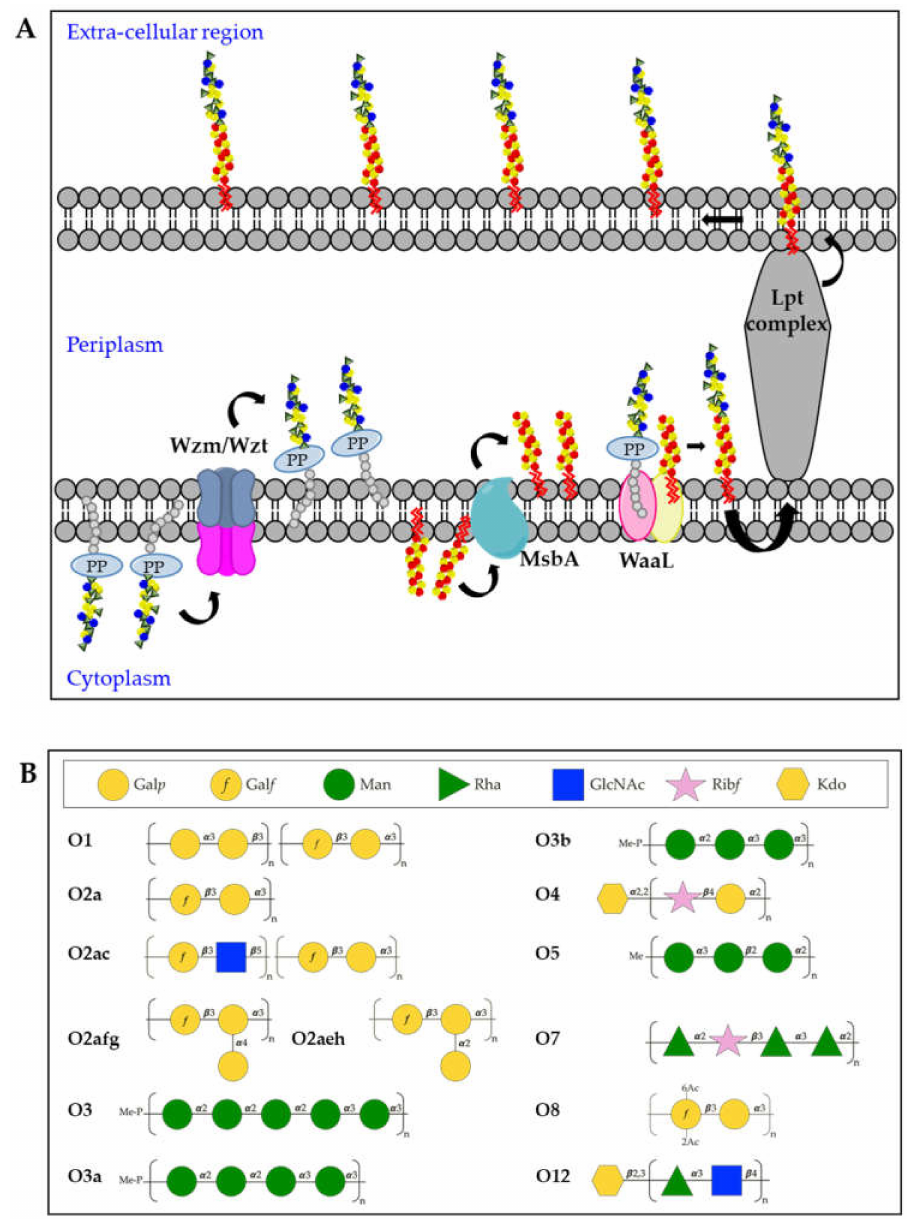
Figure 3. ( A ) Model of O-antigen biosynthesis via the adenosine triphosphate-binding cassette (ABC) transporter pathway. Und-PP-linked O-polyaccharides are processively assembled on the cytoplasmic leaflet of the inner membrane, through the sequential activity of different glycosyltransferases. The assembled O-antigen component is then transported via the Wzm/Wzt ABC transporter across the inner membrane. In the periplasmic leaflet of the inner membrane, the O-antigen is ligated to the lipid A-core oligosaccharide by WaaL and finally transported on the bacterial surface by the Lpt complex. ( B ) Structures of Kp